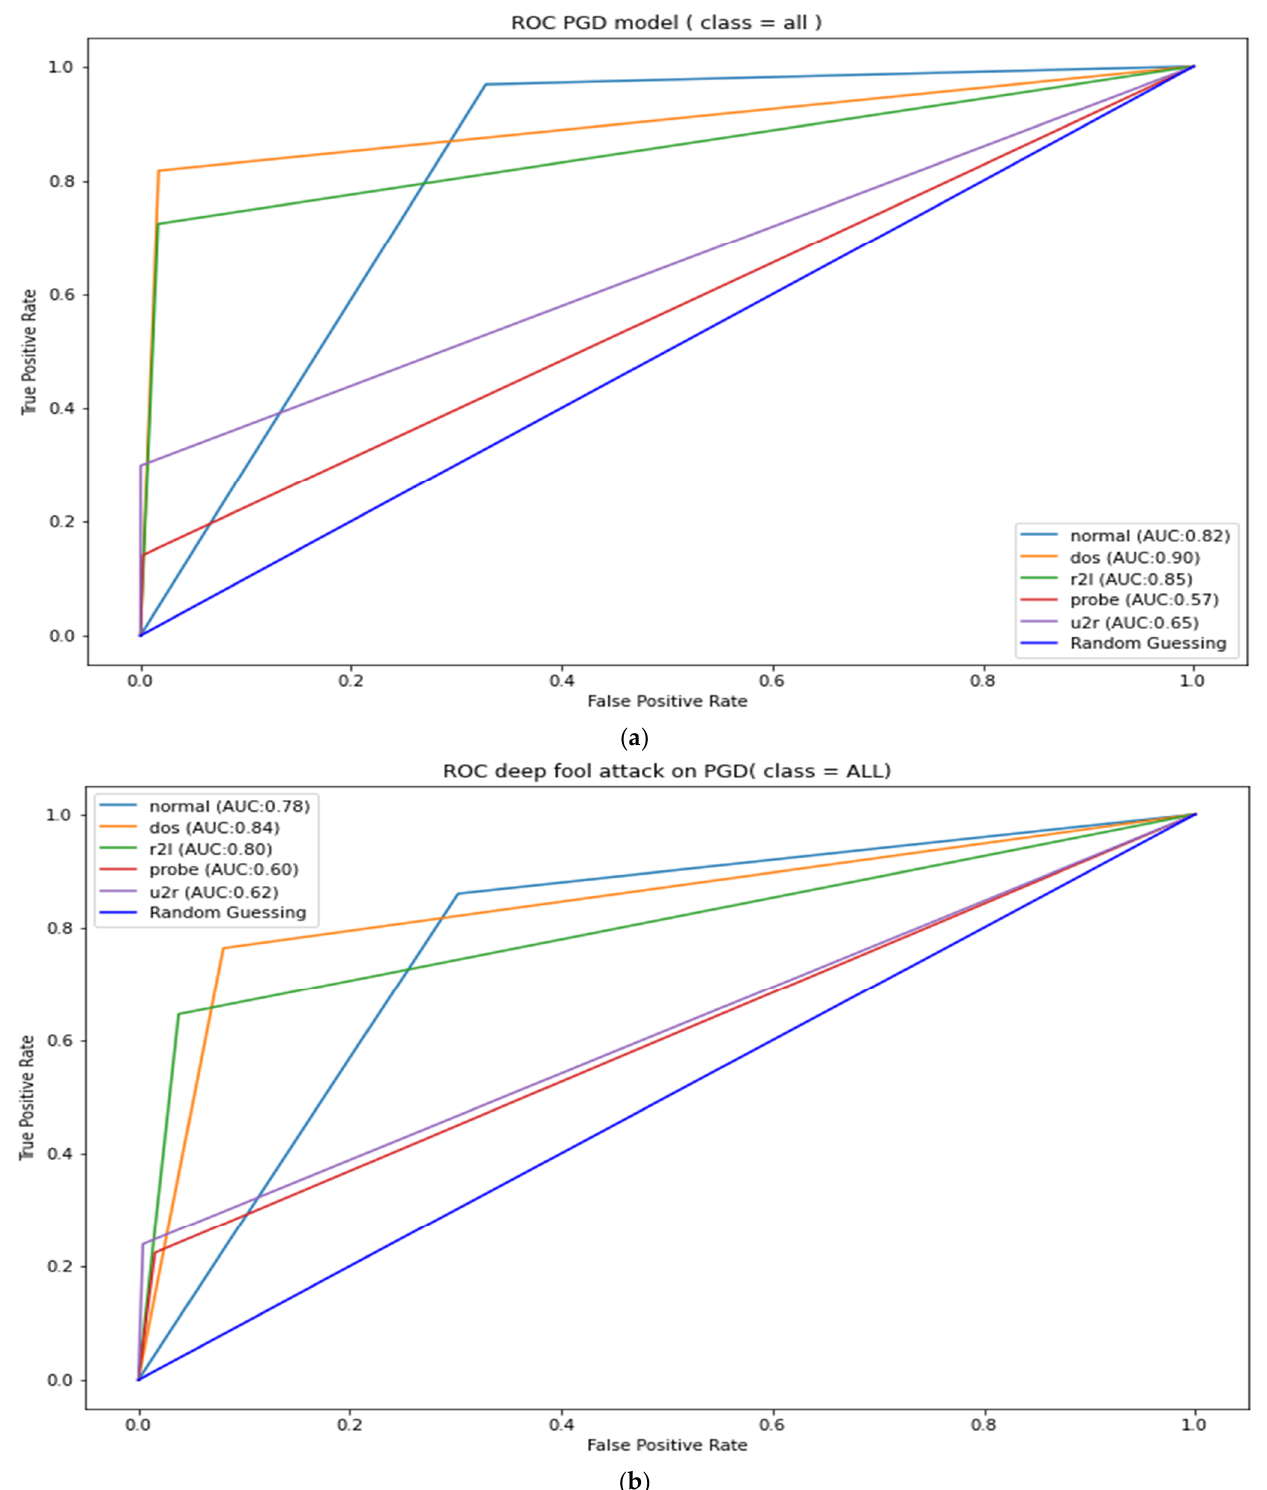
Figure A4. PGD adversarial-trained model ROC-AUC ( a ). PGD robustness test against DeepFool attacks ( b ).